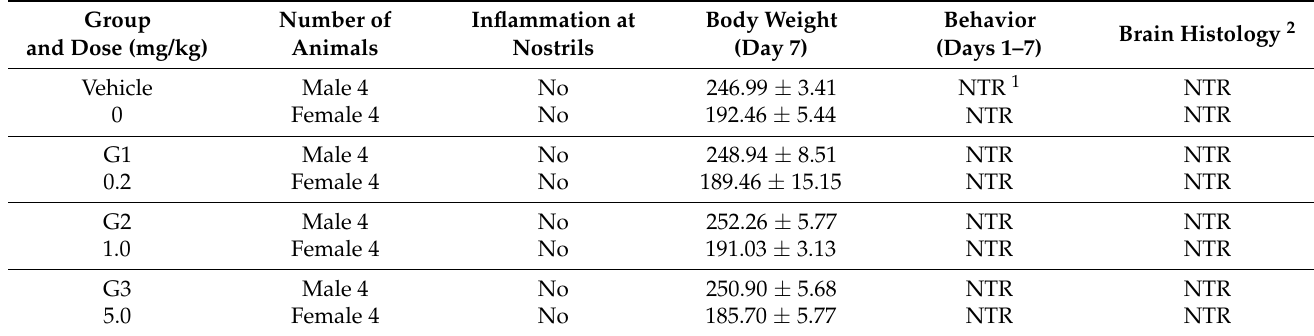
Male and female rats of the 4 experimental groups injected intranasally with doses of aqueous solutions of AmyP53 of 0.2, 1.0, and 5.0 mg/kg body weight every two days during 7 days. 1 NTR, nothing to report. 2 Brain histology. Data are expressed as mean ± SEM (n = 4). The differences in body weight between animals treated with vehicle or with AmyP53 were statistically not significant ( p > 0.05, Kruskal–Wallis